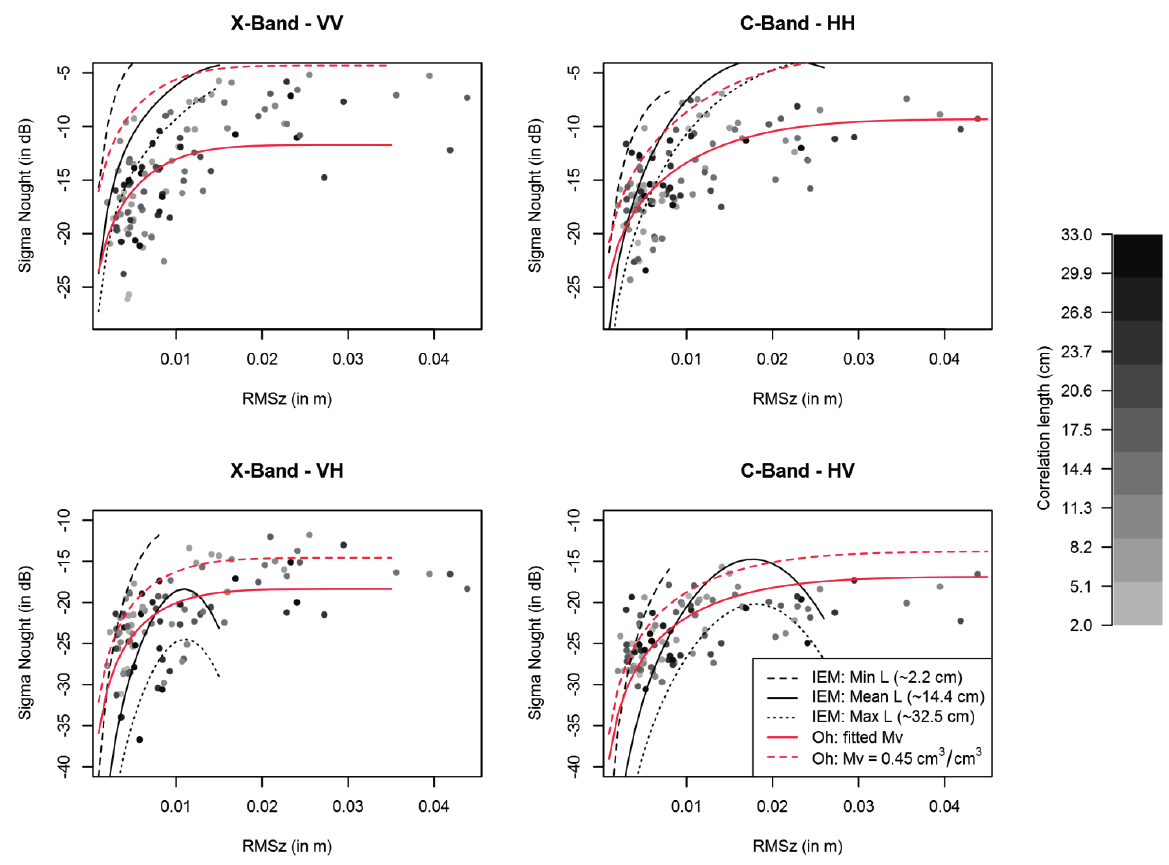
Figure 7. Model simulations of backscatter (sigma nought) in the X-band (VV and VH polarizations) and C-band (HH and HV polarizations) show the effect of RMSz. For the integral equation model (IEM) simulations, minimum, mean and maximum correlation lengths were used. An incidence angle of 40° and 34° was assumed for TerraSAR-X and Radarsat-2 respectively. The dots in the graphs are actual observations of surface roughness in the field and their backscatter observed in radar imagery. The grey scale in the images gives an impression of the correlation length at the measured sample points. The red lines are simulations based on Oh’s model for varying moisture contents (solid red lines; see the text) and moisture content of 0.45 (dashed red lines). Lines are shown for the validity domain of the